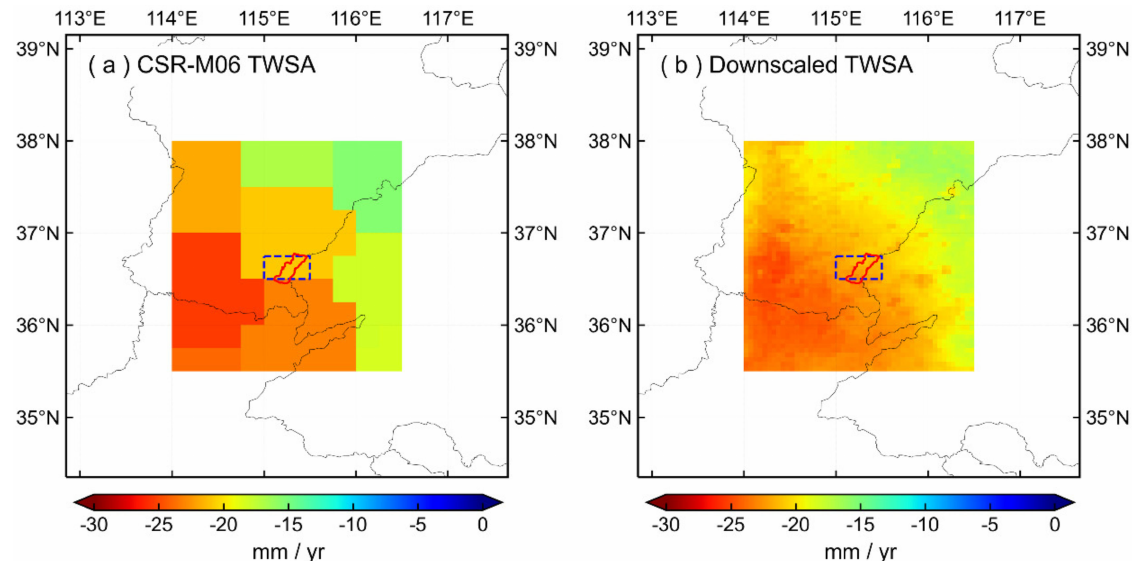
Figure 9. Spatial distribution of TWSA trends ( a ) before and ( b ) after downscaling in WS5.